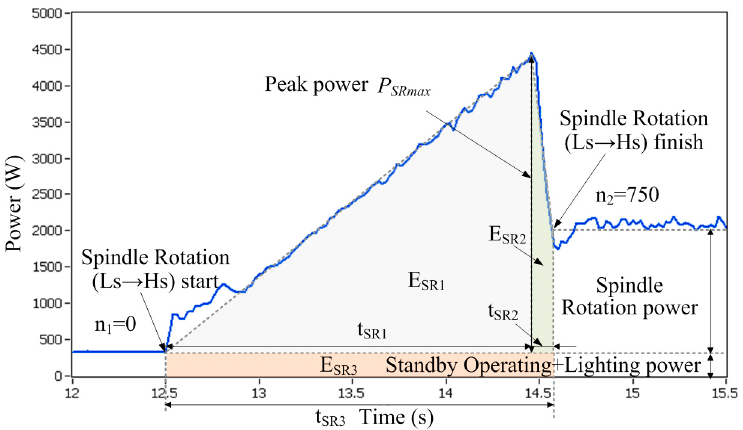
Figure 4. Power curve of spindle rotation (Ls → Hs).